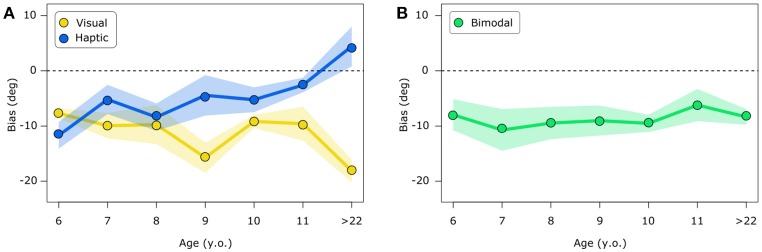
Visual and haptic biases (A) and bimodal biases (B). Biases represent the bar's tilt in degrees at which the bar is perceived to be vertical. Positive values indicate an estimation of verticality away from body tilt, negative values represent biases toward body tilt. The first ones can be interpreted as overcompensation of body tilt whereas the latter show undercompensation of body tilt. Bimodal biases are presented separately for visualization purposes. In both figures (A) and (B), shaded areas represent standard error.